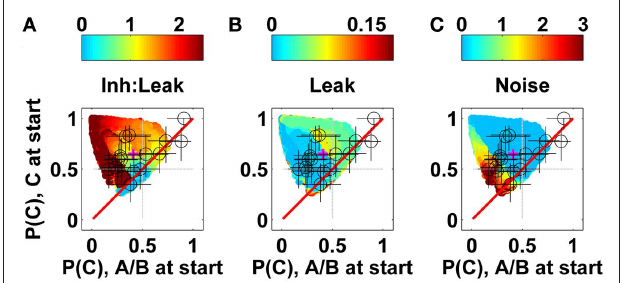
Figure 10 | Mapping of LCA predictions to parameter values. (A) The color of each filled circle corresponds to the inhibition to leak ratio; (B) the color of each point shows the leak level; (C) the color of each filled circle shows the level of the processing noise.